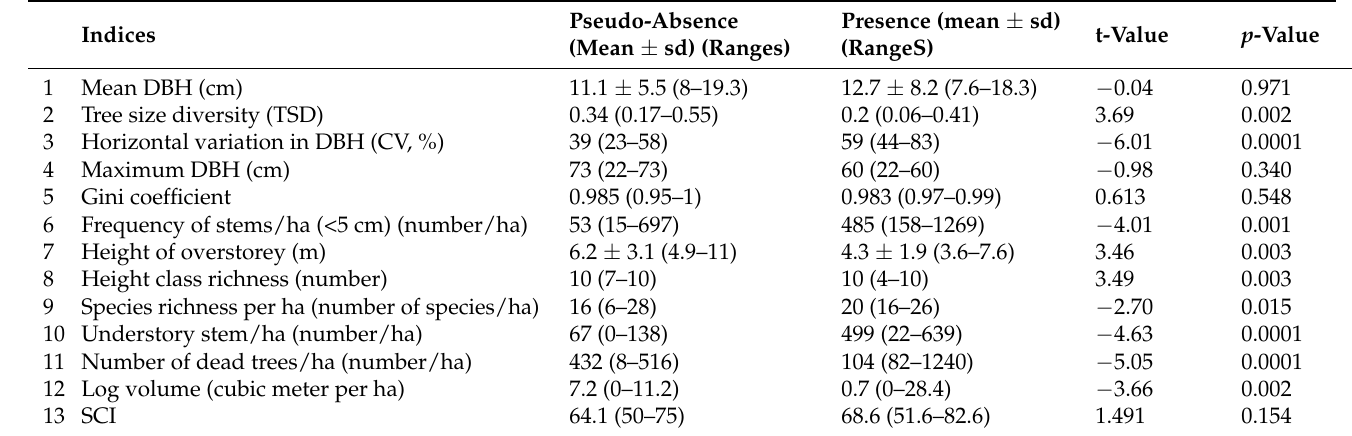
Table 3. Mean values and SD (n = 36) for a selection of structural attributes in the pseudo-absence and presence locations of the Caucasian grouse.